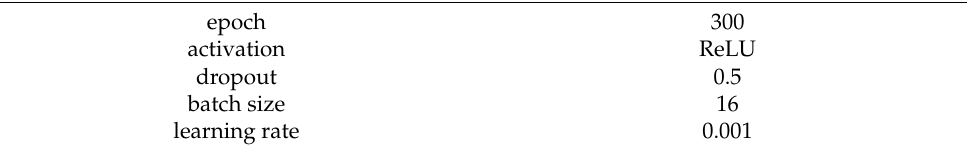
Table 2. Network model parameters.